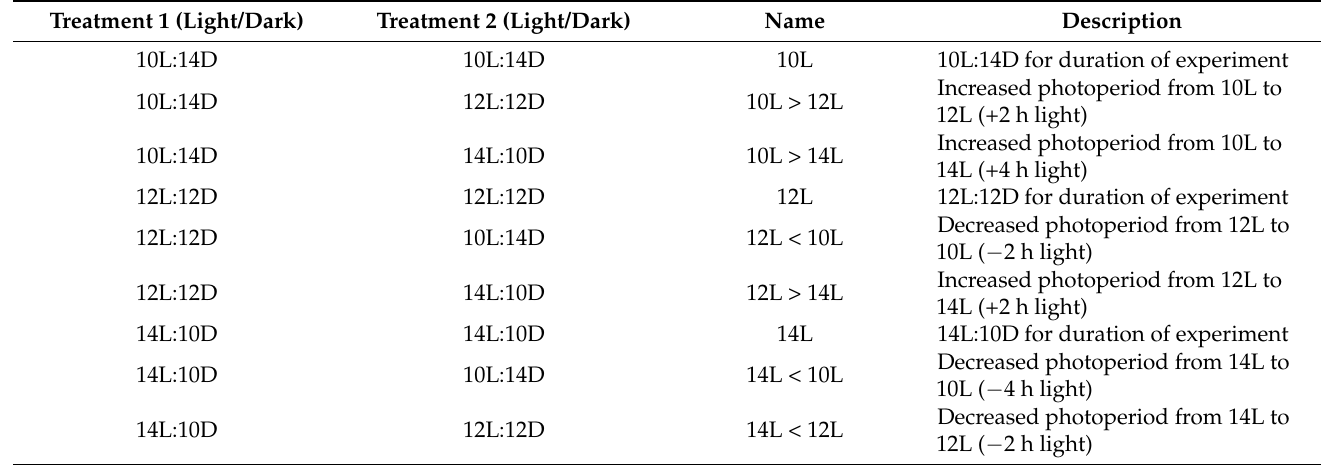
Table 2. Description of the treatments applied. Five replicates per genotype were included for each